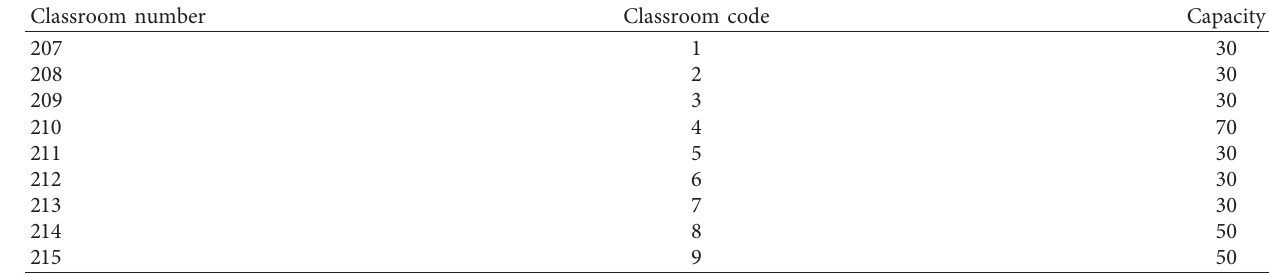
Table 11: Capacity of each classroom.